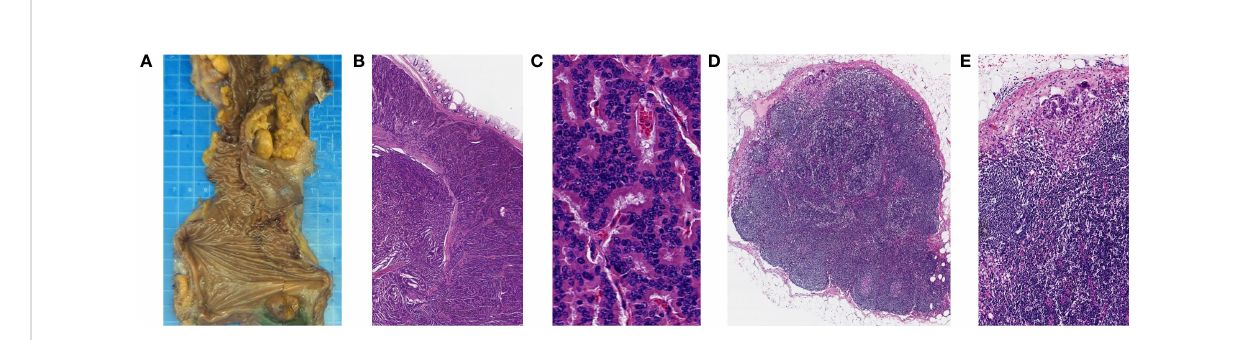
FIGURE 3 Histopathological fi ndings of the resected specimen (primary tumor and left LLNs). (A) Macroscopic fi ndings of the resected specimen. (B, C) HE staining showed that the primary tumor cells spread in the organ-like features, trabecular, glandular, and gyri-like (B magni fi cation, x20, C magni fi cation, x400). (D, E) HE staining showed that left LLNs have similar fi ndings to those of the primary tumor ( D magni fi cation, x20, E magni fi cation,